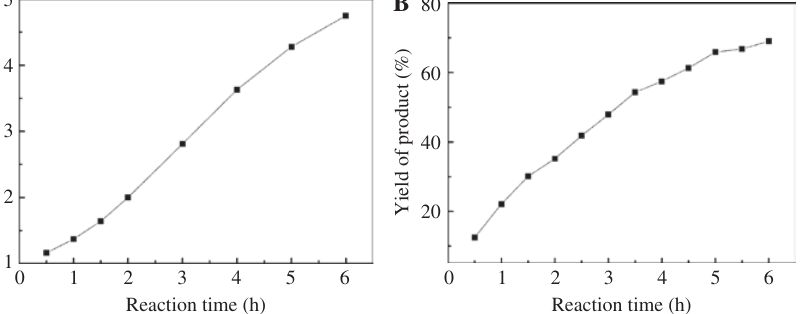
Figure 6: Effect of reaction time on average particle size (A) and yield of product (B), respectively, in the homogeneous